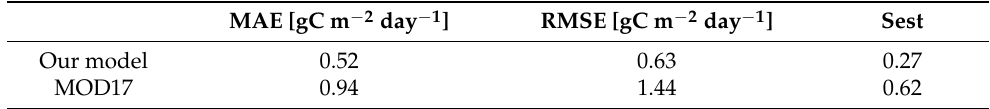
Table 7. Summary of our model and MOD17 GPP product errors.